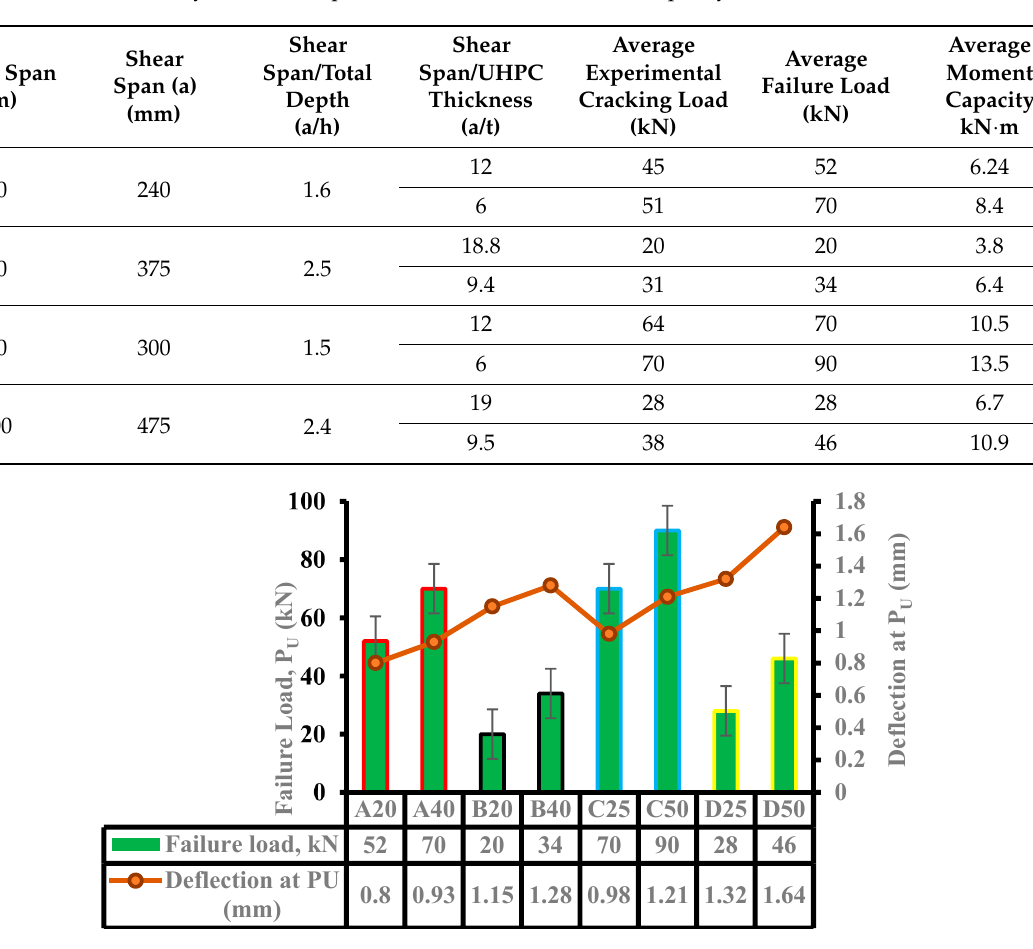
Figure 6. Average failure load and deflection of hybrid beams.